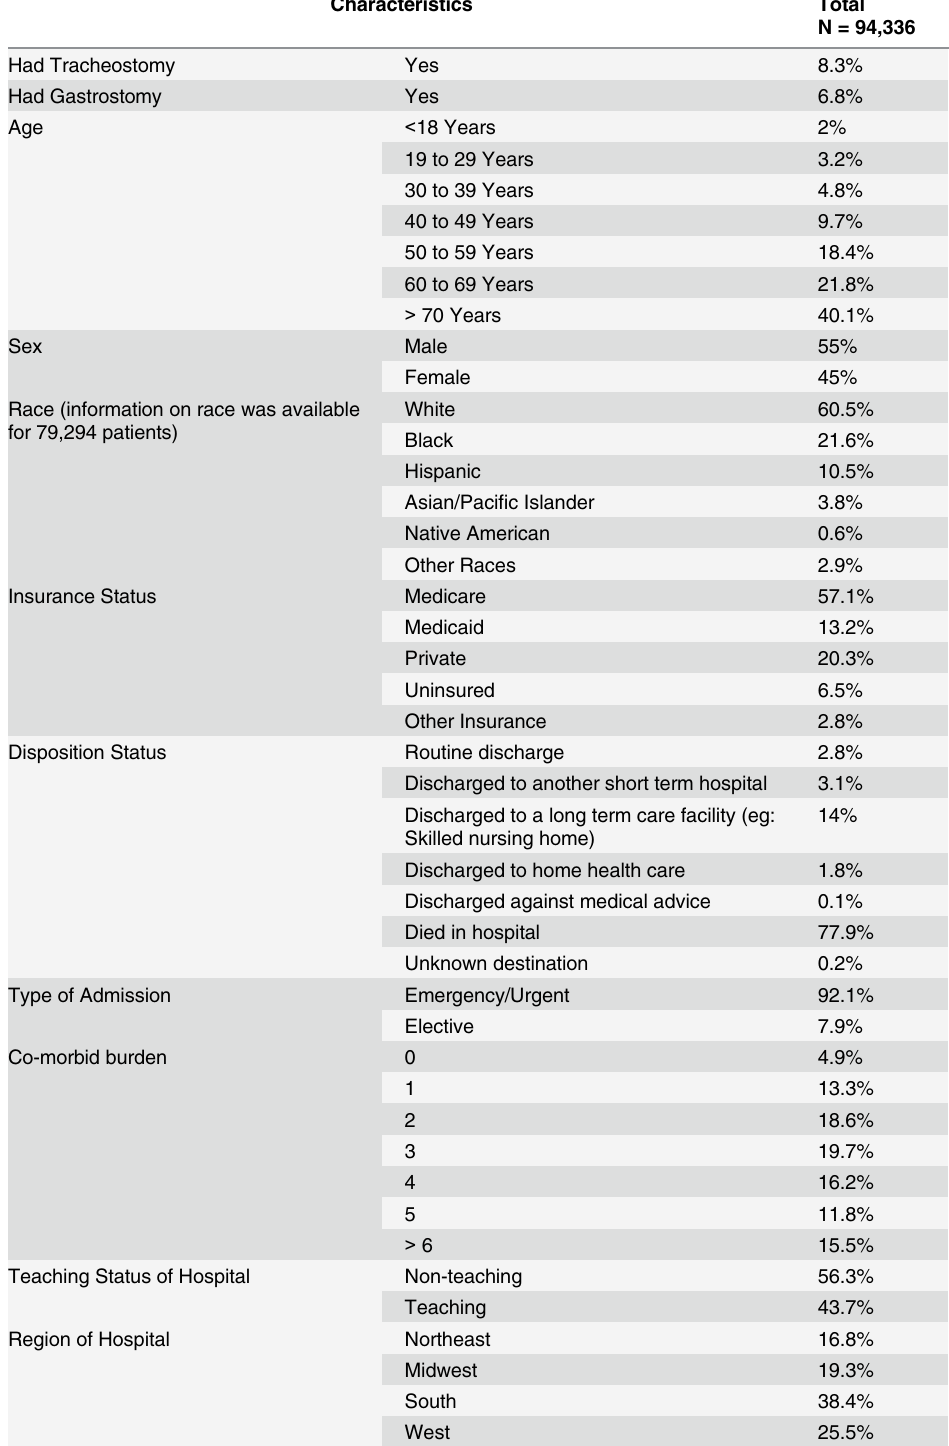
Table 1. Characteristics of Patients with AHIE and who had a